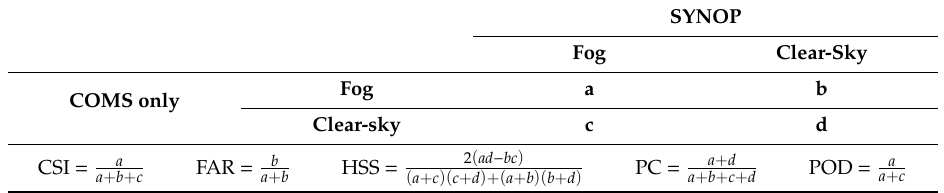
Table A3. Contingency table and definitions for the statistical skill test. HSS: Heidke Skill Scores, CSI: Critical Success Index, POD: Probability of Detection, PC: Percentage Correct, FAR: False Alarm Ratio.